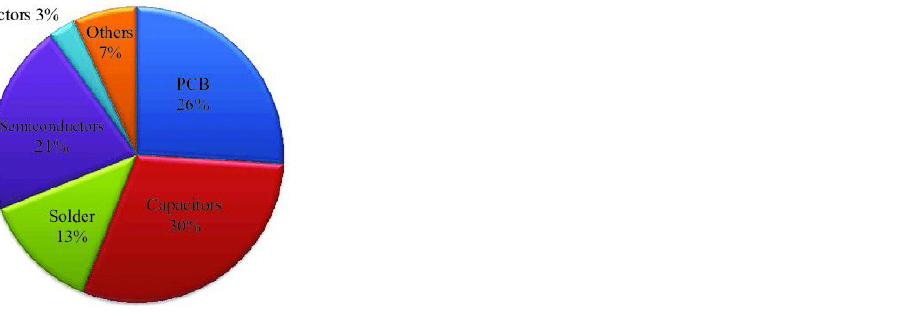
Figure 2. Contribution to converter’s failure rate from various components of a PoL converter (percentual).